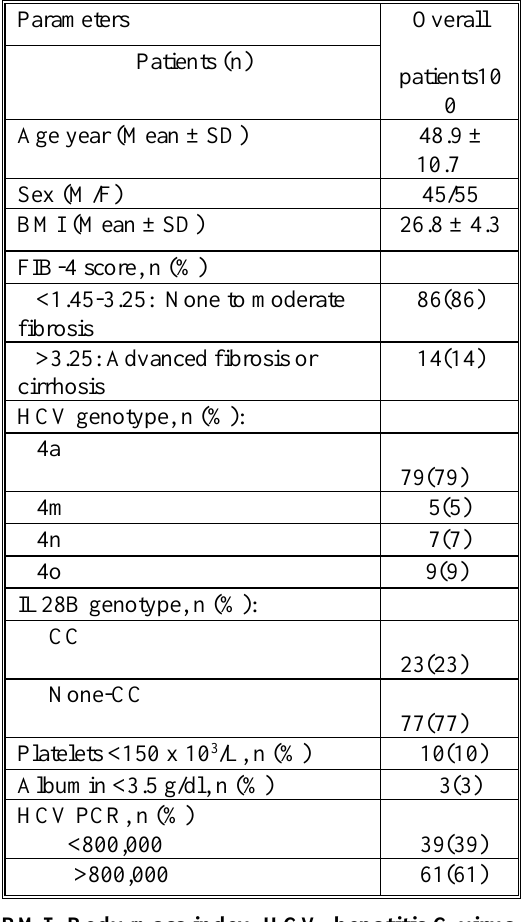
Table 1. Demographics and baseline data for treatment naivepatients with OBV/PTV/r plus RBV.